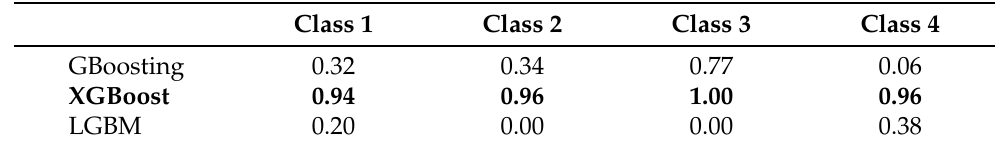
Table 5. Comparison of regressors algorithms using ( R 2 ) as the evaluation metric. This table shows that the XGBoost algorithm is the one that best predicts the number of copies of books for each of the segmentations obtained with clustering segmentation.